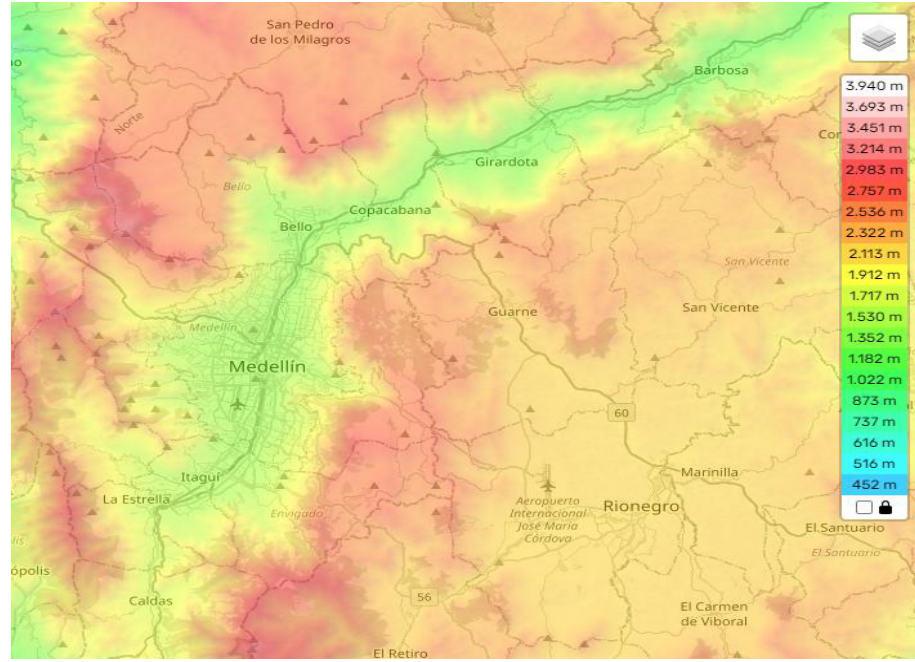
Figure 2. Elevation map of Valle de